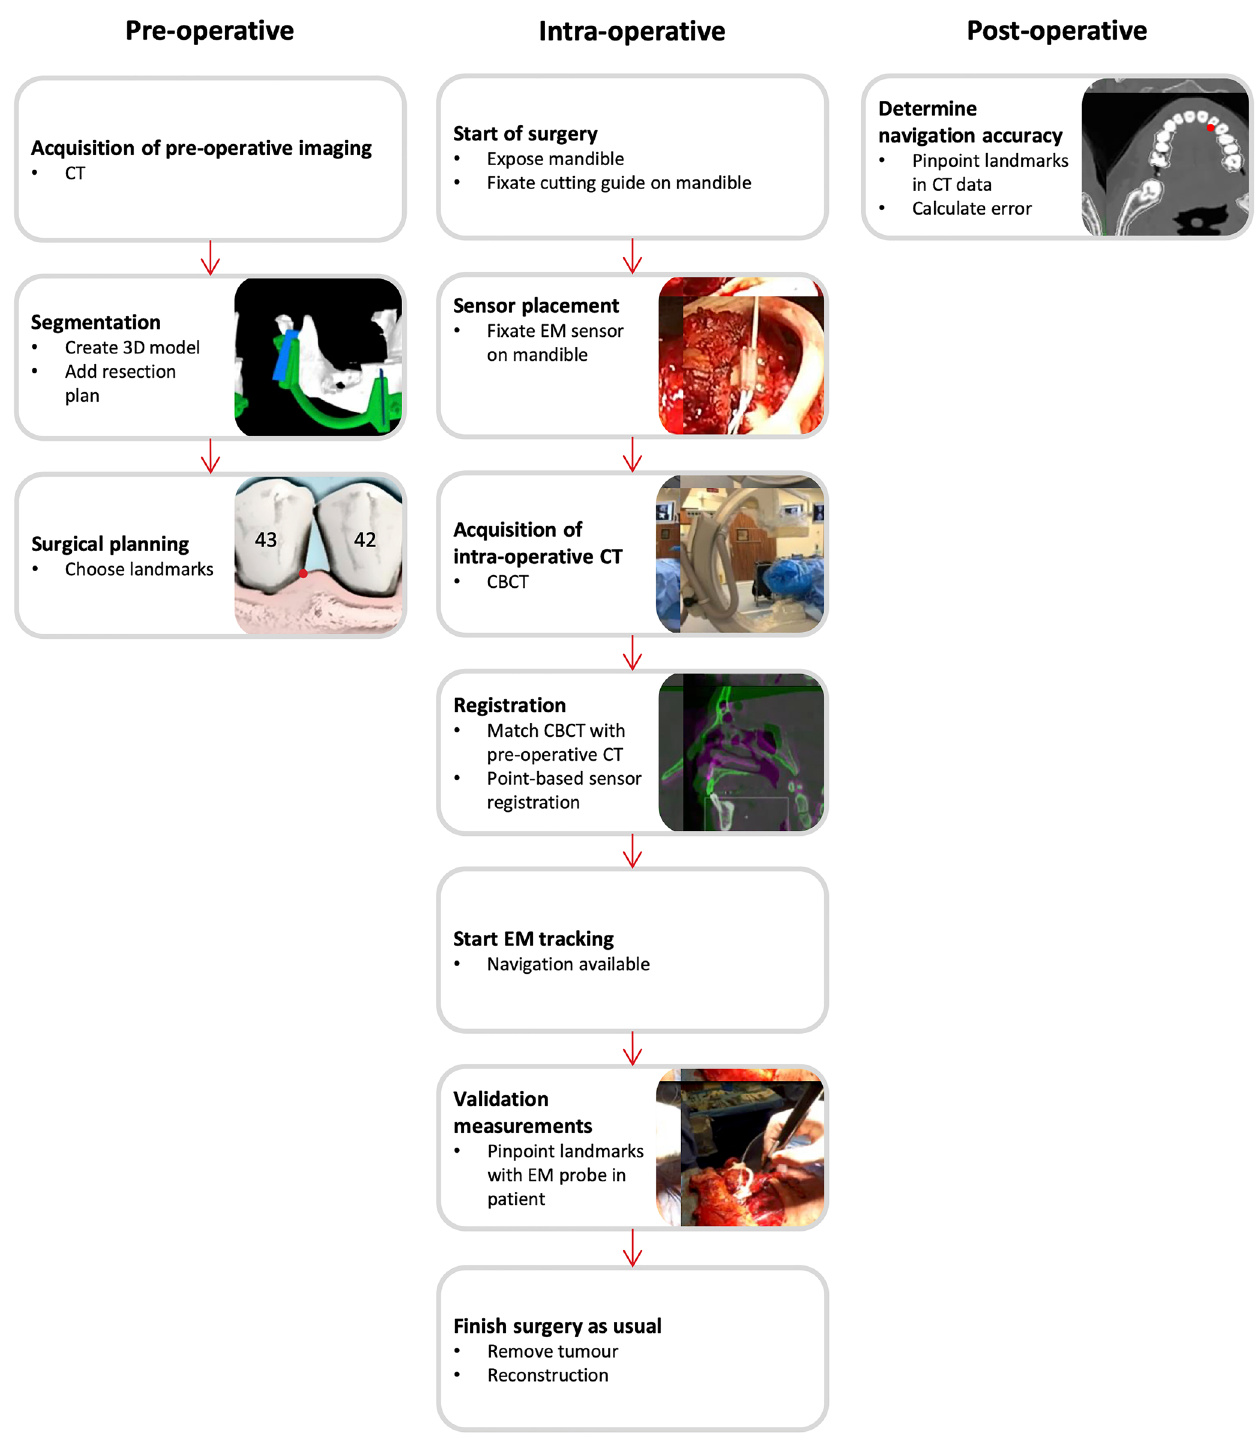
Figure 1. Overview of pre-, intra- and post-operative steps of the surgical navigation